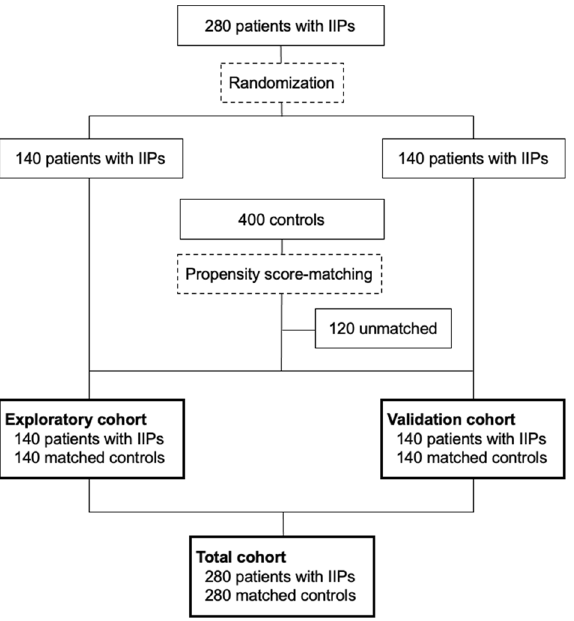
Figure 1. Diagram of the study. Patients with idiopathic interstitial pneumonias (IIPs) were randomized, stratified according to sex and %predicted forced vital capacity. Controls were selected by one-to-one propensity score-matching using age, sex, and body mass